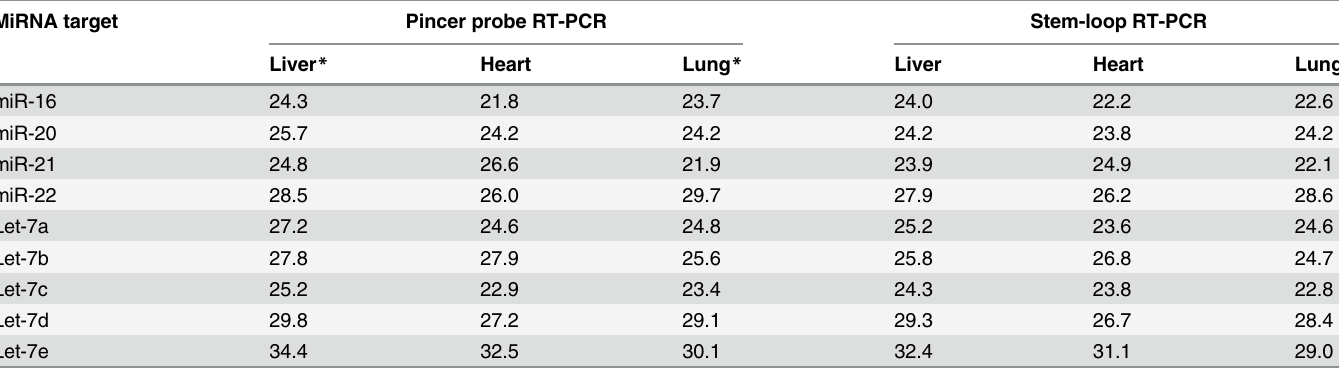
Table 1. Multiplex detection of miRNAs using pincer probe or stem-loop real-time RT-PCR. MiRNA target